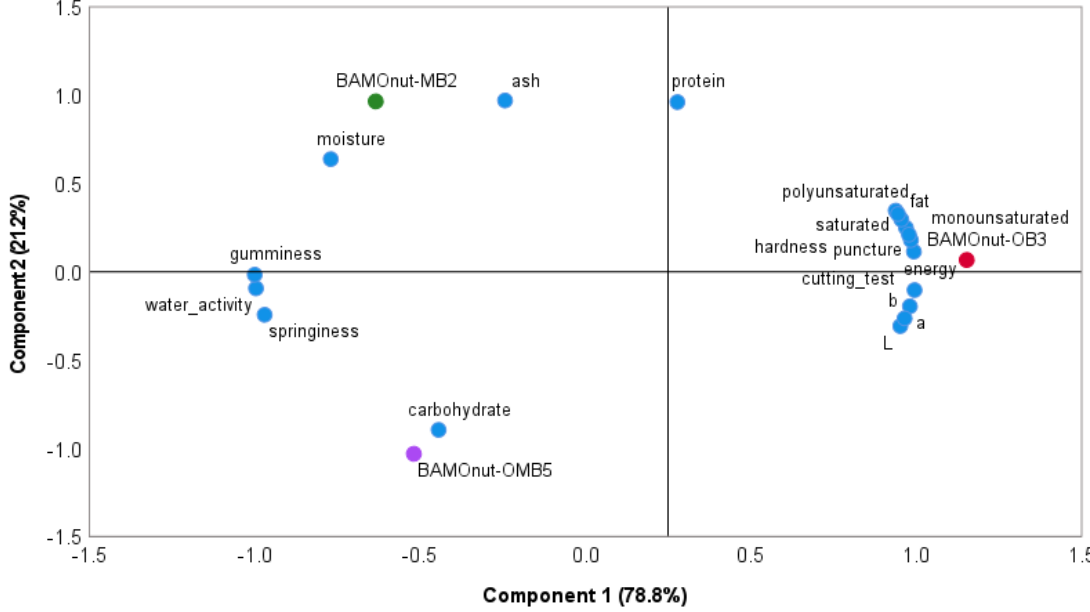
Figure 7. Principal components of Bambara groundnut– Moringa oleifera snack bars.